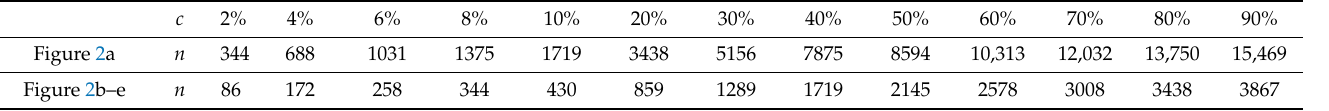
Table 2. This table provides the number of labeled samples, n , out of 21,485 total, used for each c